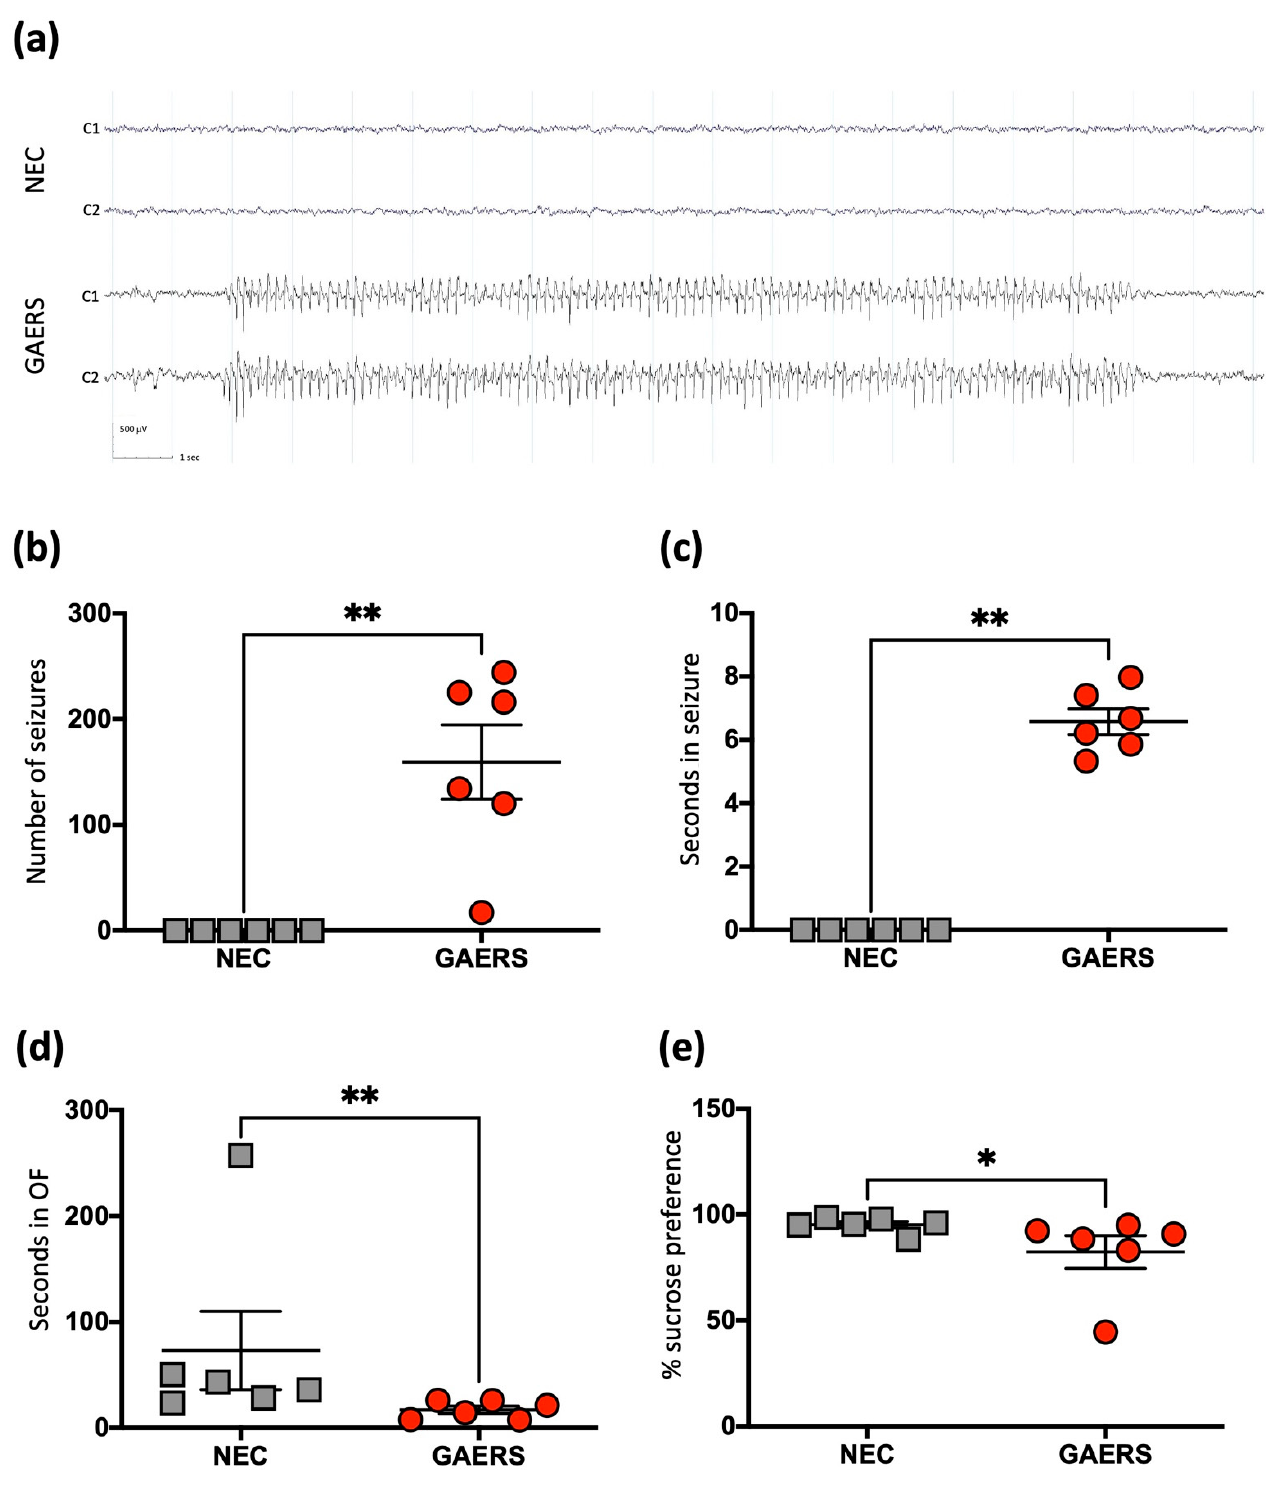
Figure 1. The EEG profile, seizure and behavioral outcomes observed in GAERS and NEC groups. ( a ) A recorded example of the characteristic EEG trace of the NEC and GAERS rats. ( b – e ) A two-tailed t -test was used for all comparisons, data shown as mean with standard error of the mean (SEM), significance indicated with asterisks: (*) at p < 0.05 and (**) at p < 0.01; ( b ) The number of seizures observed for individual rats. ( c ) The average time spent in seizures for individual rats. ( d ) The amount of time spent in the center of the open field. ( e ) The percentage of sucrose preference.